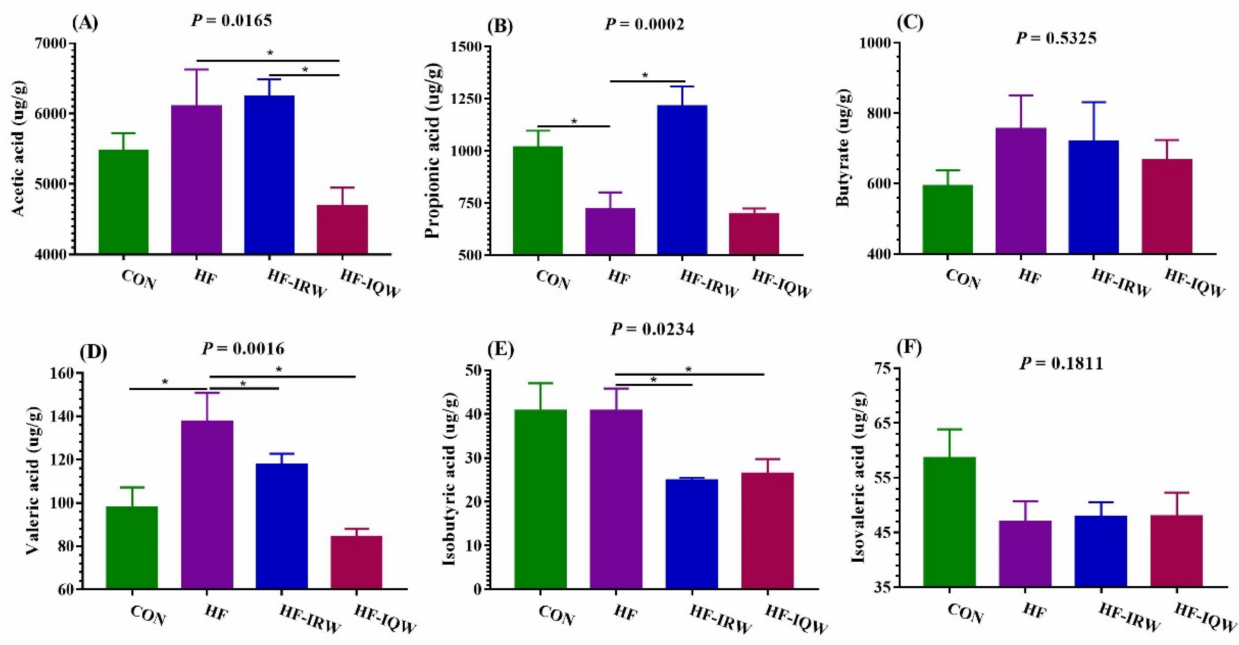
Figure 7. Effects of egg protein transferrin-derived peptides IRW (lle-Arg-Trp) and IQW (lle-Gln-Trp) on SCFAs (short-chain fatty acid) in the feces of mice fed an HF diet. ( A ) Concentration of acetic acid; ( B ) concentration of propionic acid; ( C ) concentration of butyrate; ( D ) concentration of Valeric acid; ( E ) concentration of Isobutyric acid; ( F ) concentration of Isovaleric acid. * indicates p < 0.05 between the HF (high-fat diet) group and other